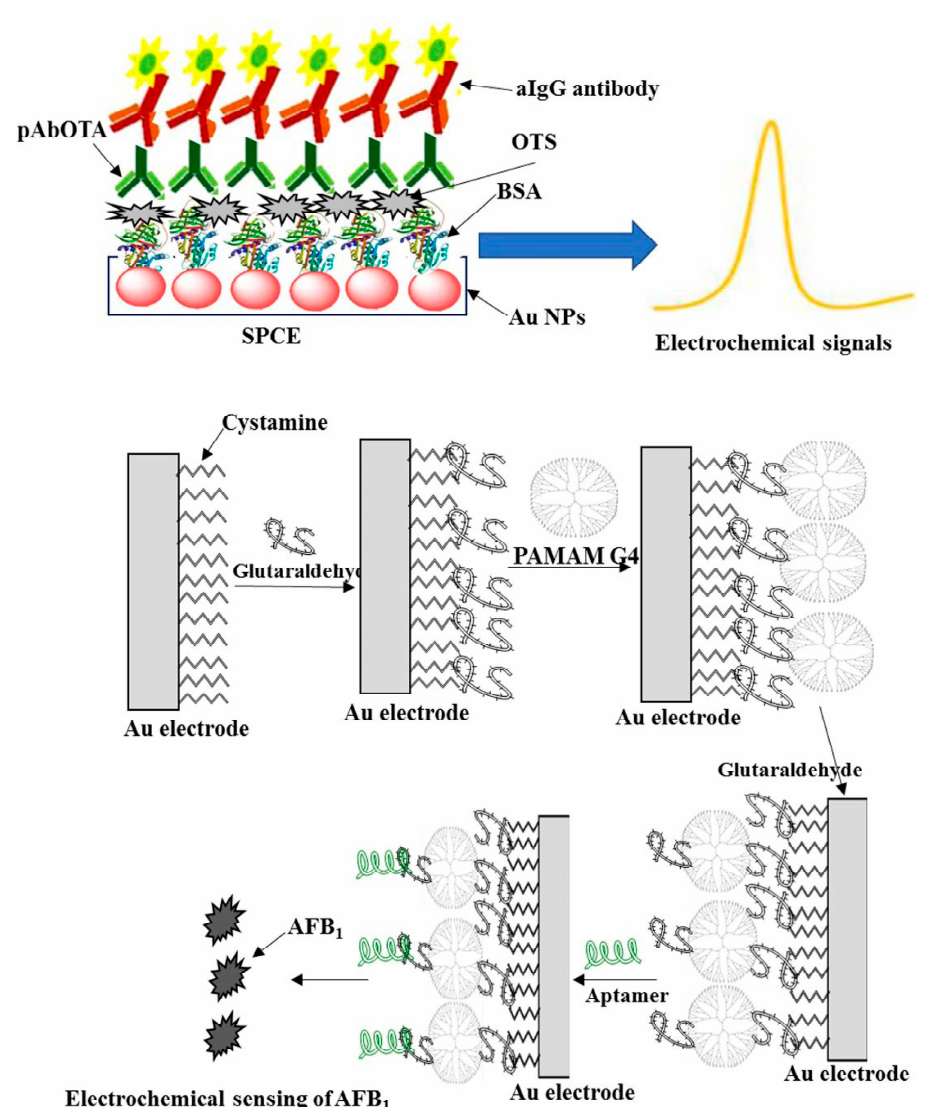
Figure 10. Adsorption of Au NPs, BSA-OTA-pAbOTA, and aIgG antibodies on the surface of SPCE for electrochemical detection of OTA and Schematic for the attachment of aptamer on the surfaces of Au electrode, using cystamine and glutaraldehyde PAMAM G4 as ligands for the formation of self-assembled layer and their interaction with aptamer for specific and selective electrochemical detection of AFB1. Reproduced from [14]. Copyright 2018 Elsevier.